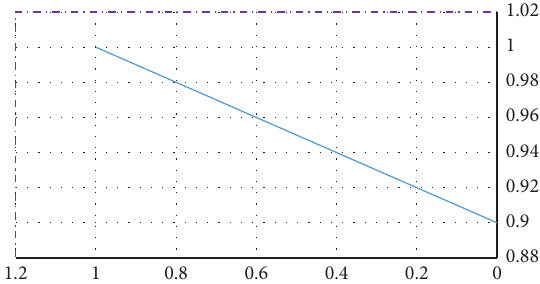
Figure 10: Chart of the restriction part of 􏽥 U